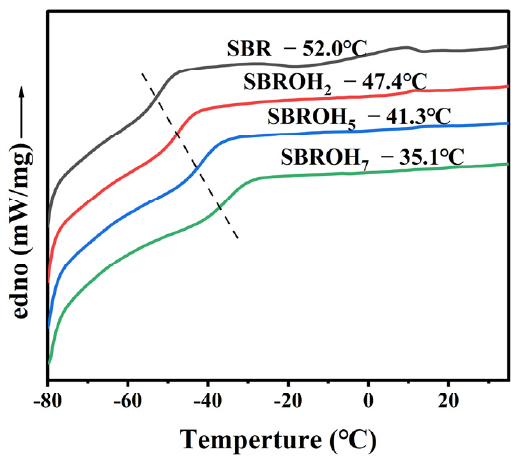
Figure 5. DSC curves of SBROH x .